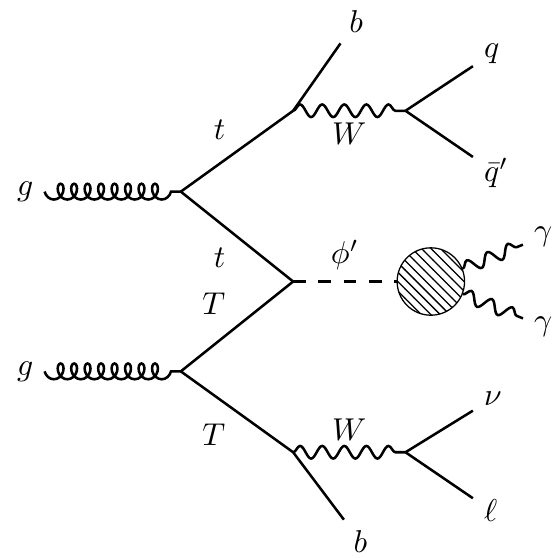
Figure 2 . “ T - t Fusion” Feynman